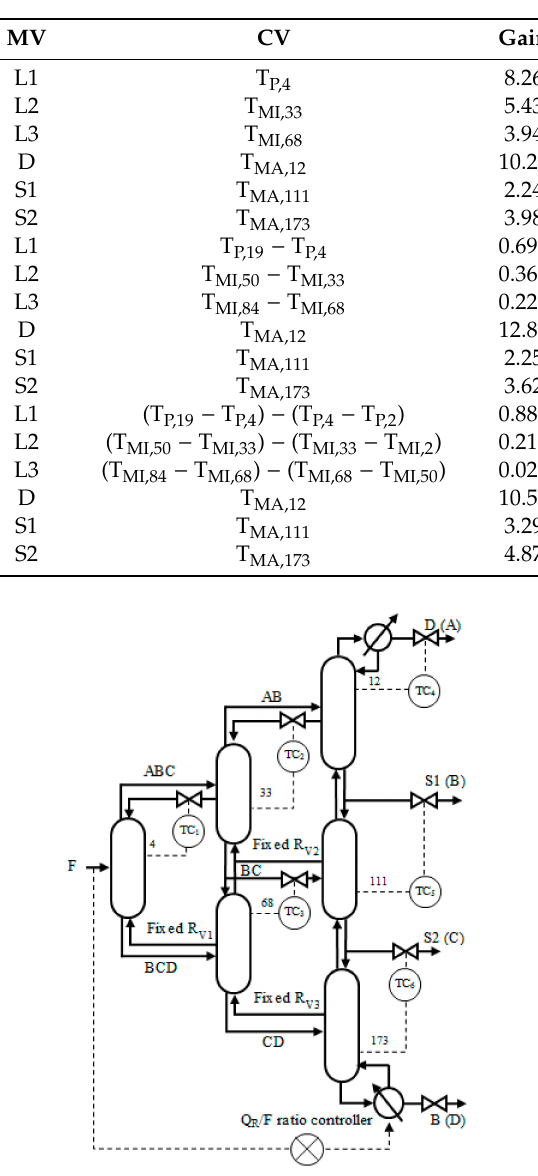
Figure 7. Temperature control (TC)